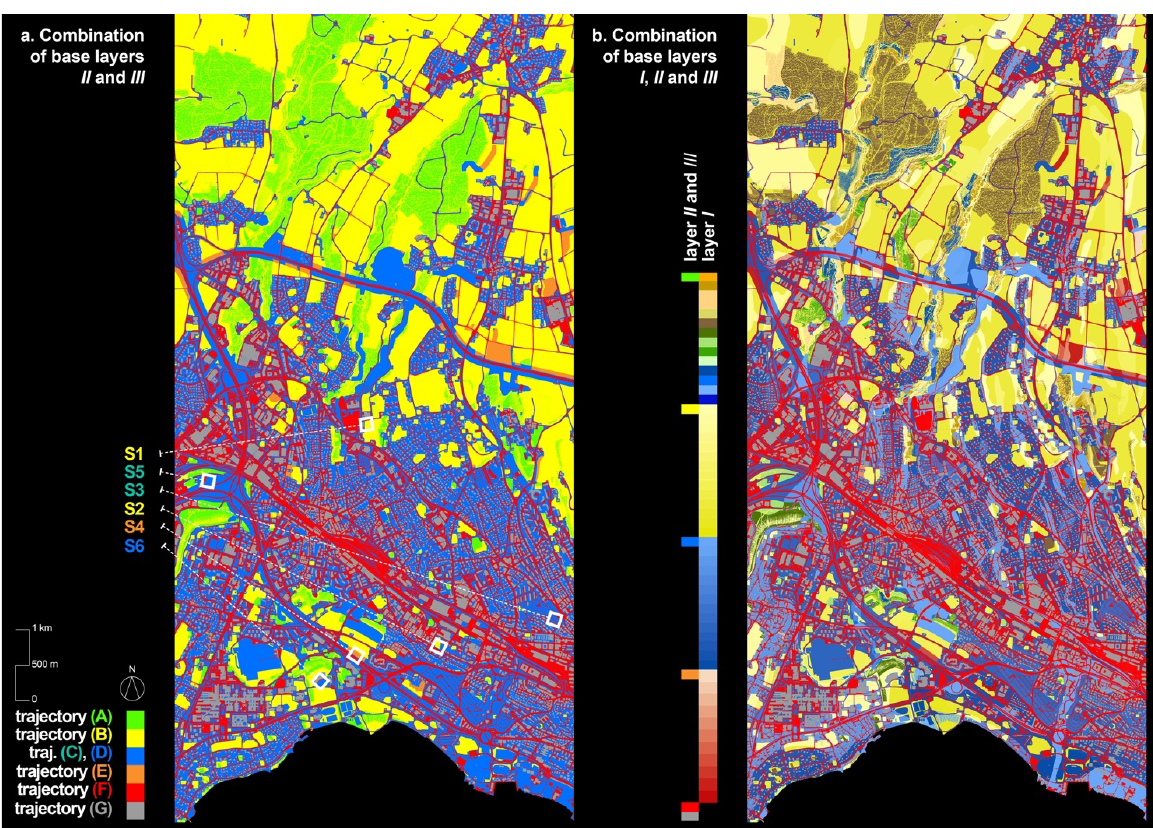
Figure 12. Draft concept map of potential urban soils, including the location of the soils studied. Source: